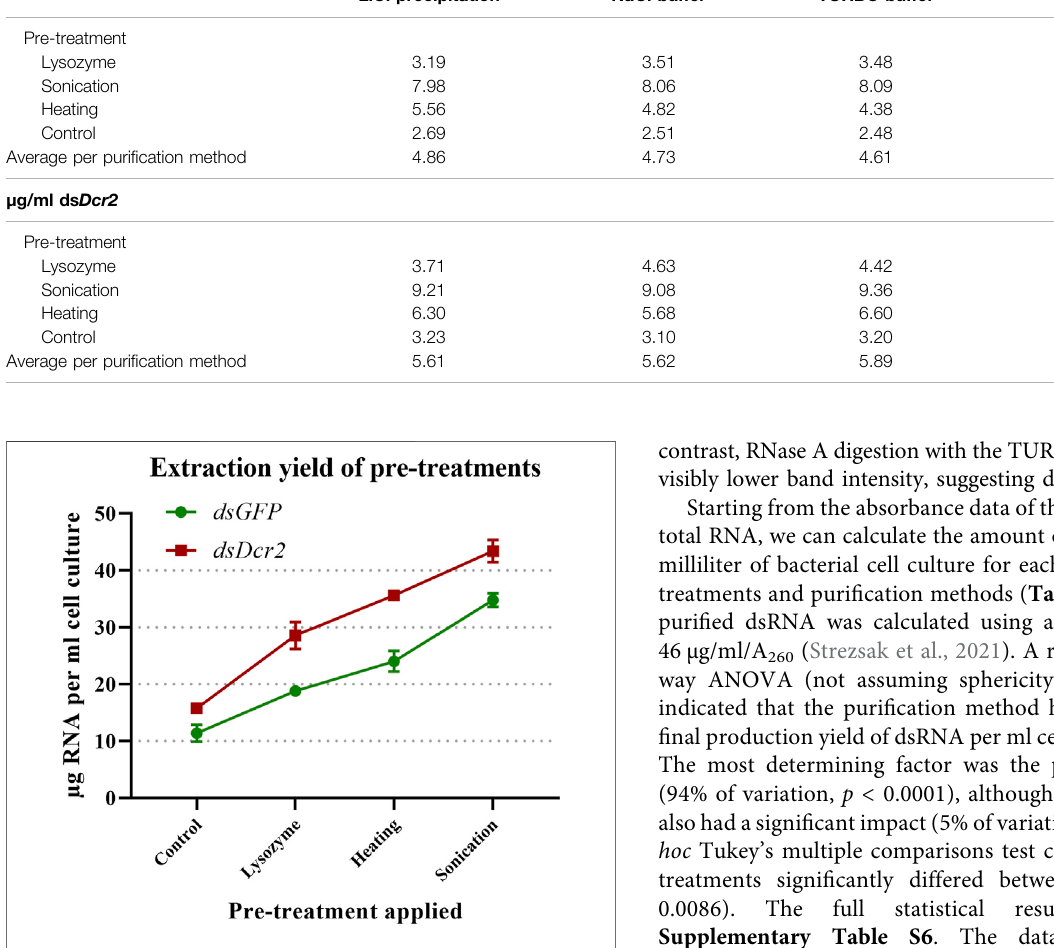
FIGURE 1 | Impact on total RNA extraction ef fi ciency of three pre- treatments. Concentrated bacterial cells expressing two dsRNA constructs ( dsGFP or dsDcr2 ) were freeze-thawed ten times and then subjected to cell- disruption treatments. The total RNA was then extracted through a phenol/guanidine-based method and the concentration measured through a spectrophotometer. Four replicates were tested for each condition (32 samples in total). Symbols indicate the mean, error bars the standard deviation. All pre-treatments signi fi cantly ( p < 0.0001, two-way ANOVA with Tukey ’ s multiple comparisons test) increased the extraction yields compared to the control method and differed between each other.